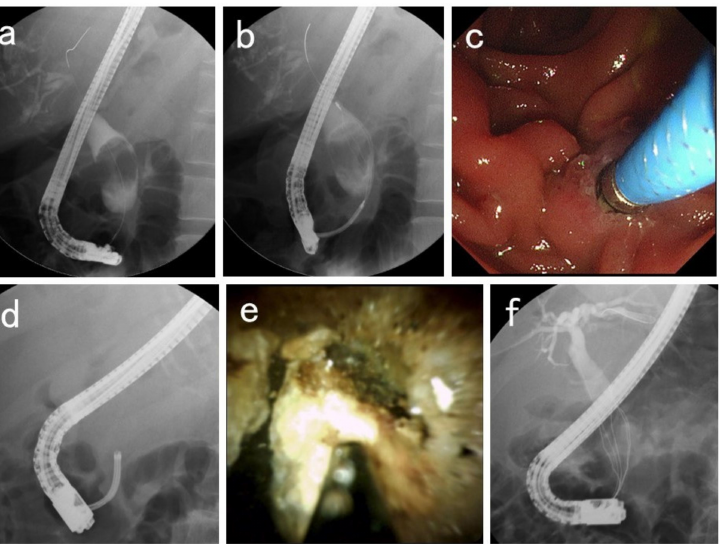
Figure 1. Electrohydraulic lithotripsy techniques using peroral cholangioscopy under endoscopic ret- rograde cholangiopancreatography guidance. ( a ) Cholangiography image showing a large common bile duct stone. ( b ) Stone removal is impossible using standard techniques. ( c , d ) A cholangioscope is inserted into the bile duct. ( e ) Electrohydraulic lithotripsy was performed under cholangioscopic guidance using an electrohydraulic lithotripsy probe. ( f ) Stone removal was performed using the standard technique after fragmentation of the common bile duct